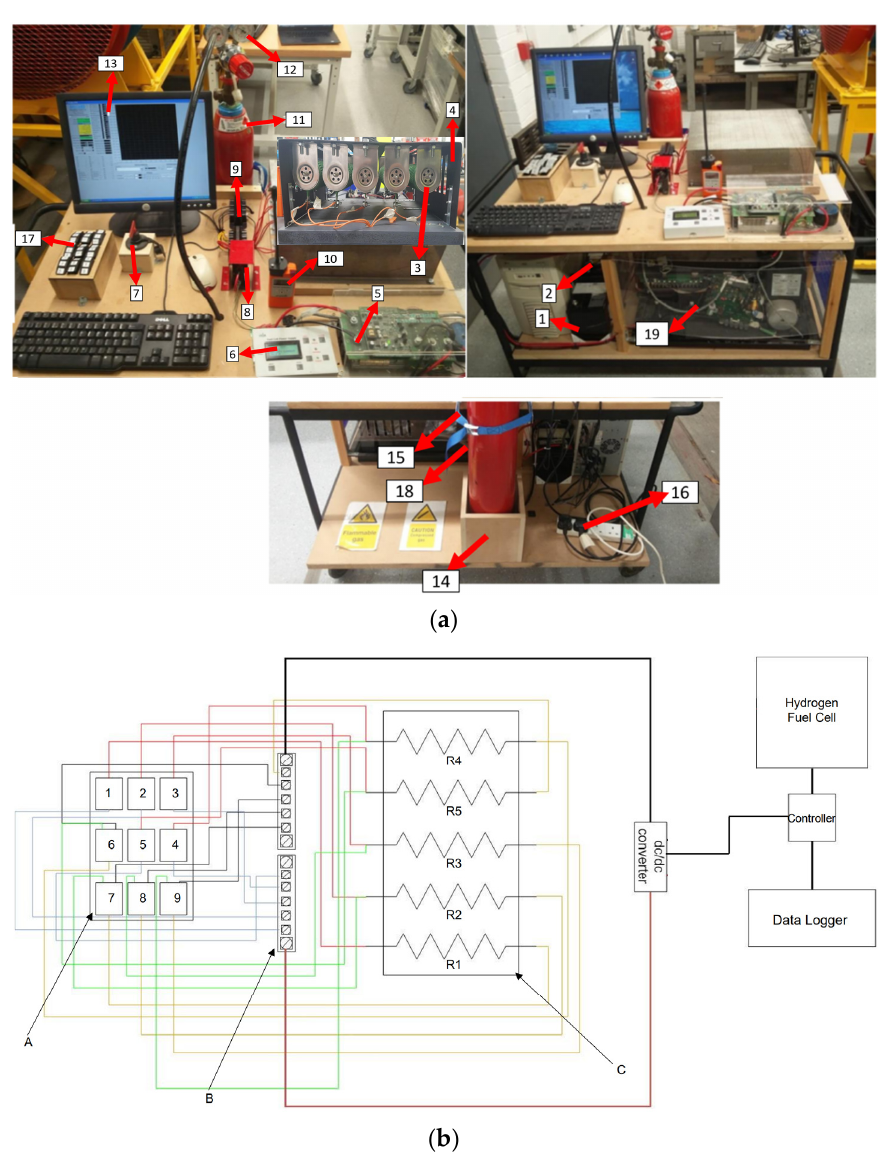
Figure 2. Diagram of the 1.2 kW Ballard fuel cell used for the investigation.